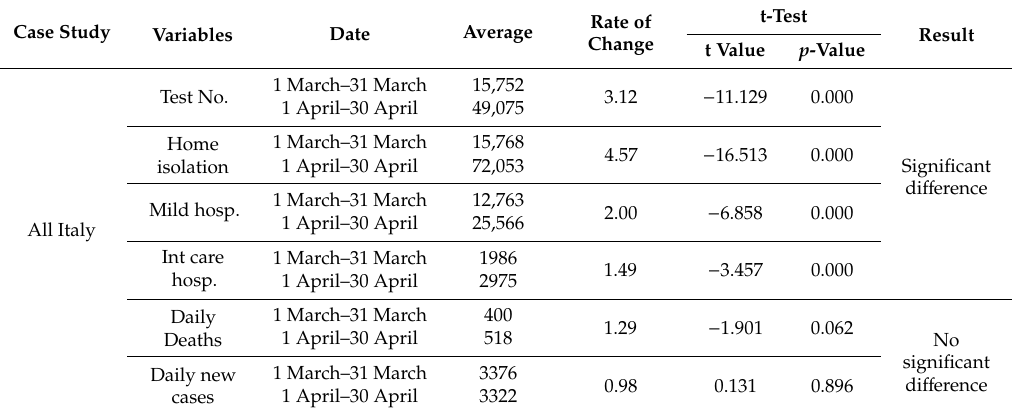
Table 2. T-test results for two periods for the whole of